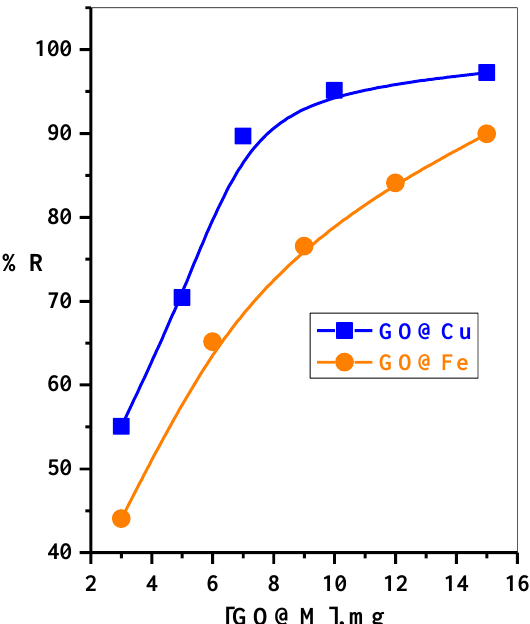
Figure 7. Effect of GO@M dose/50 mL dye solution on removal percent of MB-dye; GO@Cu (t = 2.5 min, [MB] = 50 mg L − 1 , V = 50 mL, pH = 7, T = 25 °C) and GO@Fe (t = 2.5 min, [MB] = 30 mg L − 1 , V = 50 mL, pH = 7, T = 30 °C) from aqueous solution.